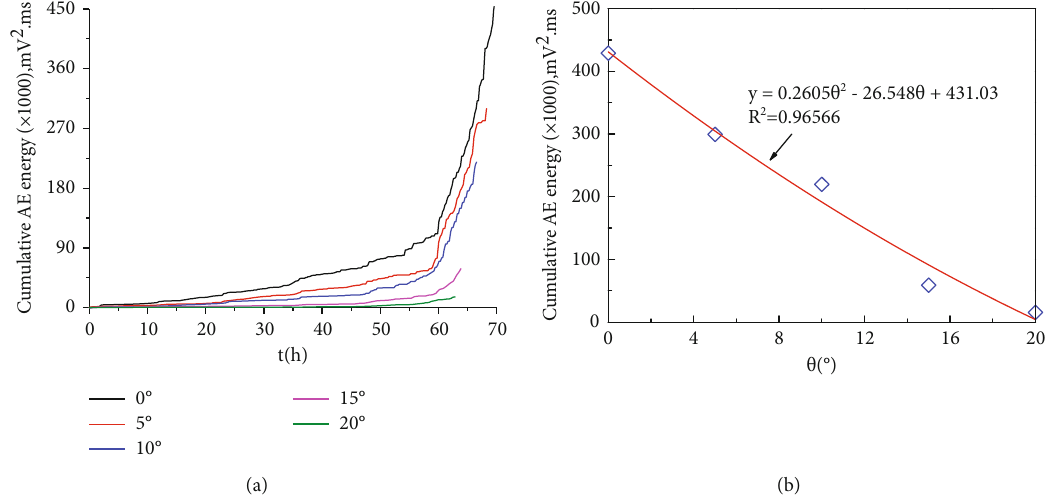
Figure 13: Variation of accumulative AE energy with (a) time and (b) inclination